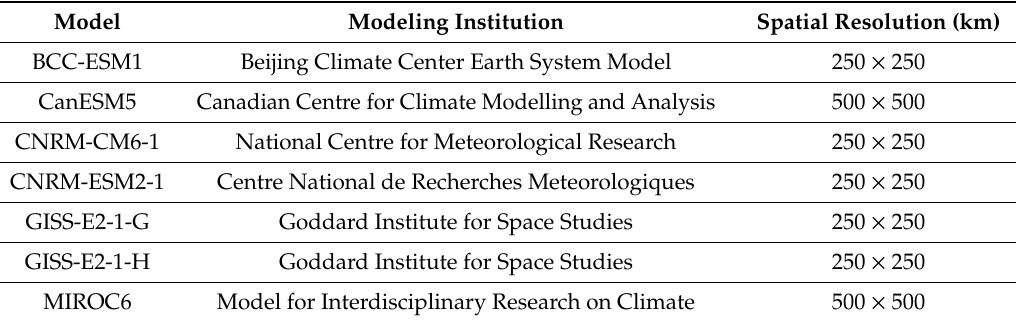
Table 1. CMIP6 models employed with their respective spatial